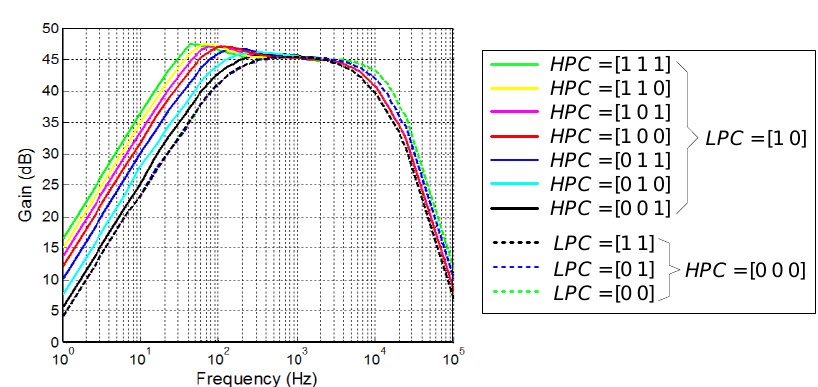
Figure 13. Measured LNA frequency response for different settings of the HP C and LP C tuning words.